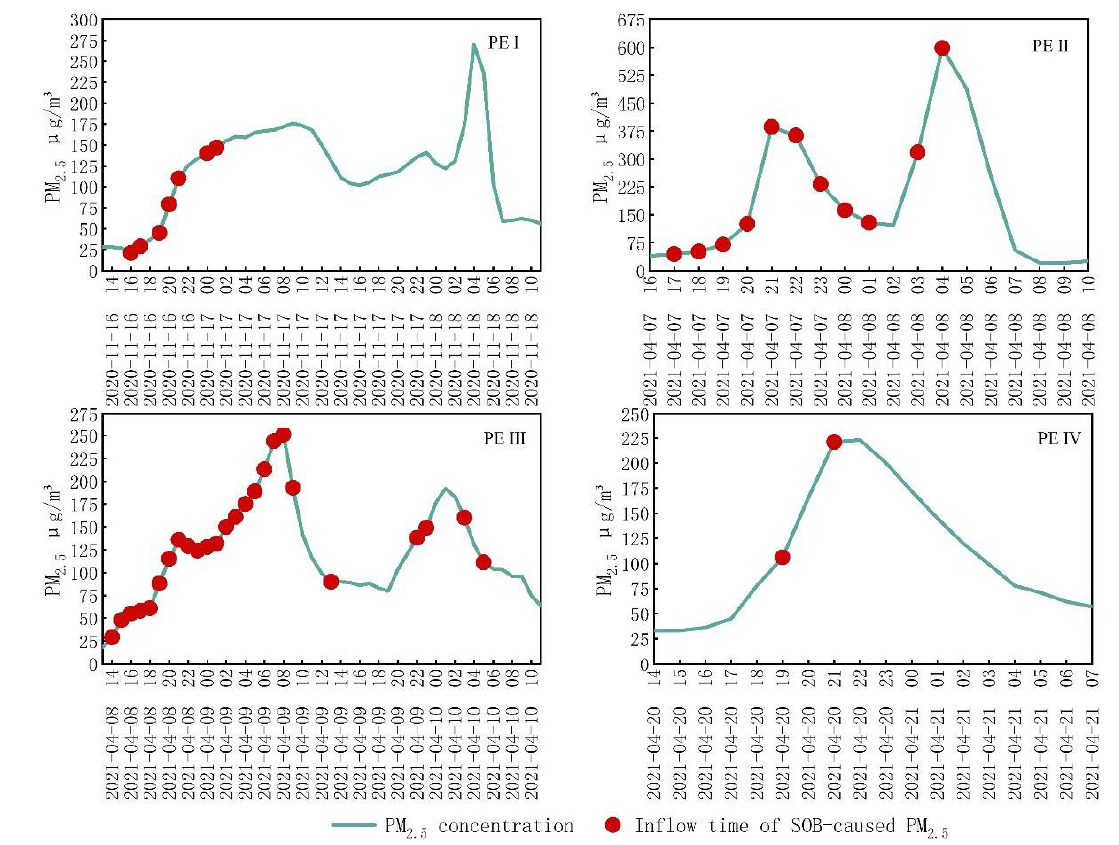
Figure 7. The inflow time into the city of the PM 2.5 from identified straw open burning